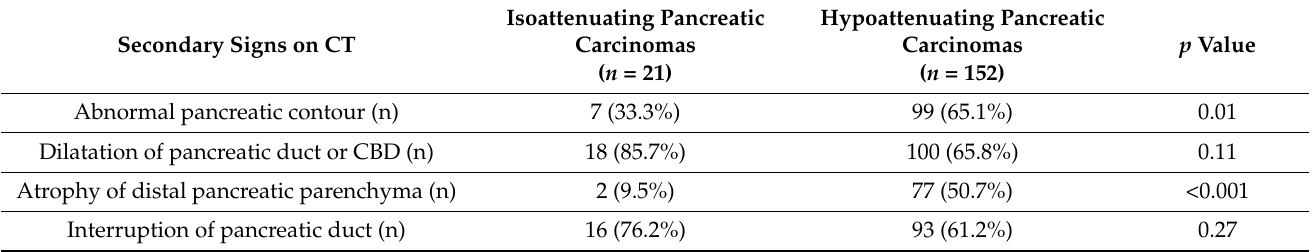
Figure 2. Isoattenuating pancreatic carcinoma on CT in pancreatic ( A ) and portal venous phase ( B ) with dilated common bile duct ( C ). EUS-FNA confirming the tumor of the head of the pancreas ( D ). Table 3. Frequency of secondary signs of isoatenuating and hypoattenuating pancreatic carcinomas on CT.